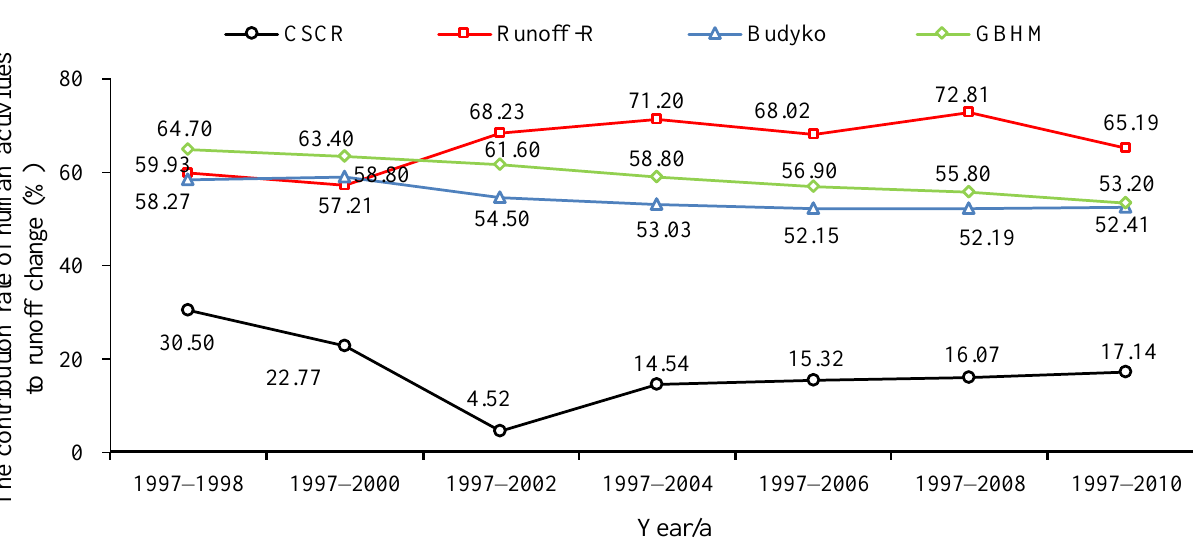
Figure 12. In the change period (3), Uncertainty analysis diagram for the four methods in change period (3) (SCRCQ = slope change rate cumulative quantity; Runoff-R = the runoff reduction method). The trend calculated by the Budyko method is more stable; the runoff reduction method produced a zigzag pattern. The SCRCQ method and runoff reduction method were basically stable after 2004. The hydrologic model and Budyko method consider not only hydrological and meteorological data when calculating the runoff contribution rate, but also the changes in the subsurface of the basin, making it more stable and reliable than